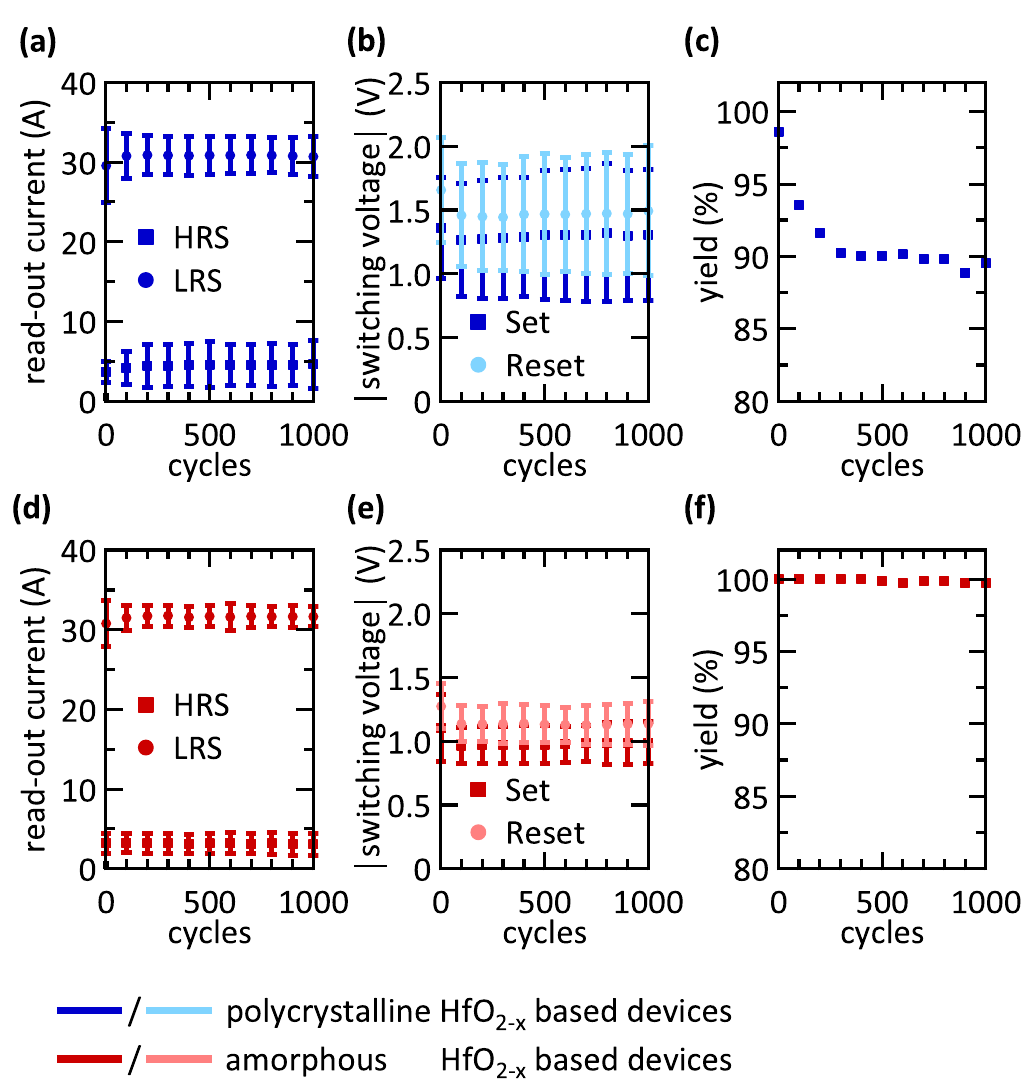
Correspond to polycrystalline devices, while ( d – f ) correspond to amorphous devices. For every data point 128 devices are taken into account. The error bars denote the standard deviation of the averaged measurement data. The read-out and switching times are equal to 10